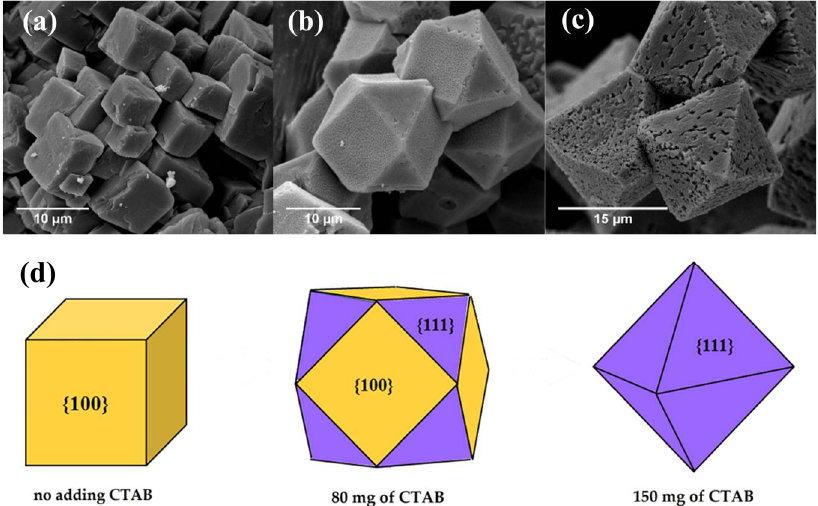
Figure 3. SEM images of IRMOF-3 with various amounts of CTAB at 0 mg ( a ), 80 mg ( b ), and 150 mg ( c ) and illustration of the shape evolution of the crystals: the yellow facets represent {100}, while the violet facets represent {111} ( d ).